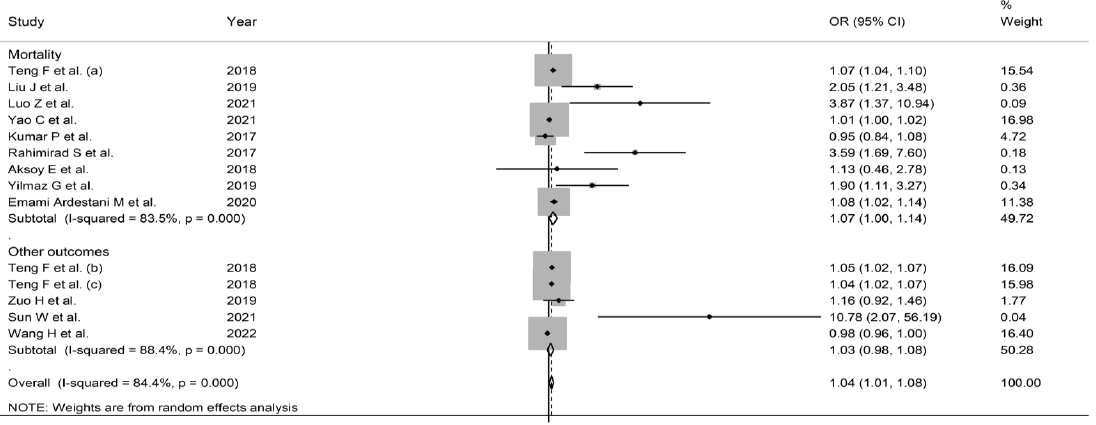
Figure 5. Forest plot of the association between the neutrophil-to-lymphocyte ratio, using odds ratios, and adverse outcomes according to specific endpoints (mortality vs. other outcomes). p = 0.000 indicates a p -value < 0.001.